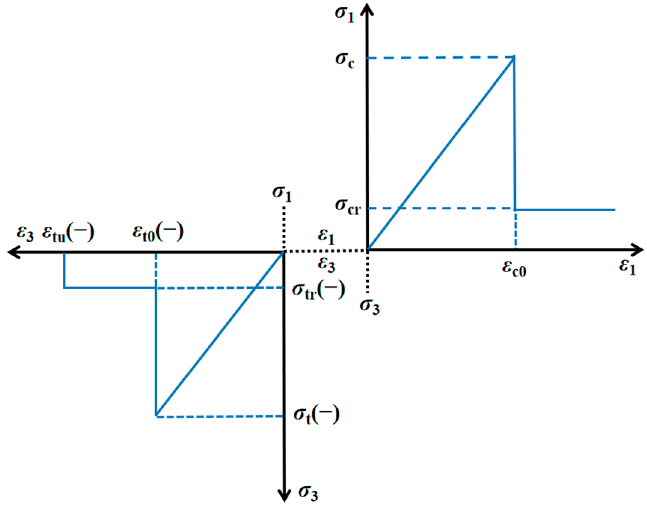
Figure 1. Mechanical property distribution for five various homogeneous specimens (both strength and elastic modulus follow the same distribution).